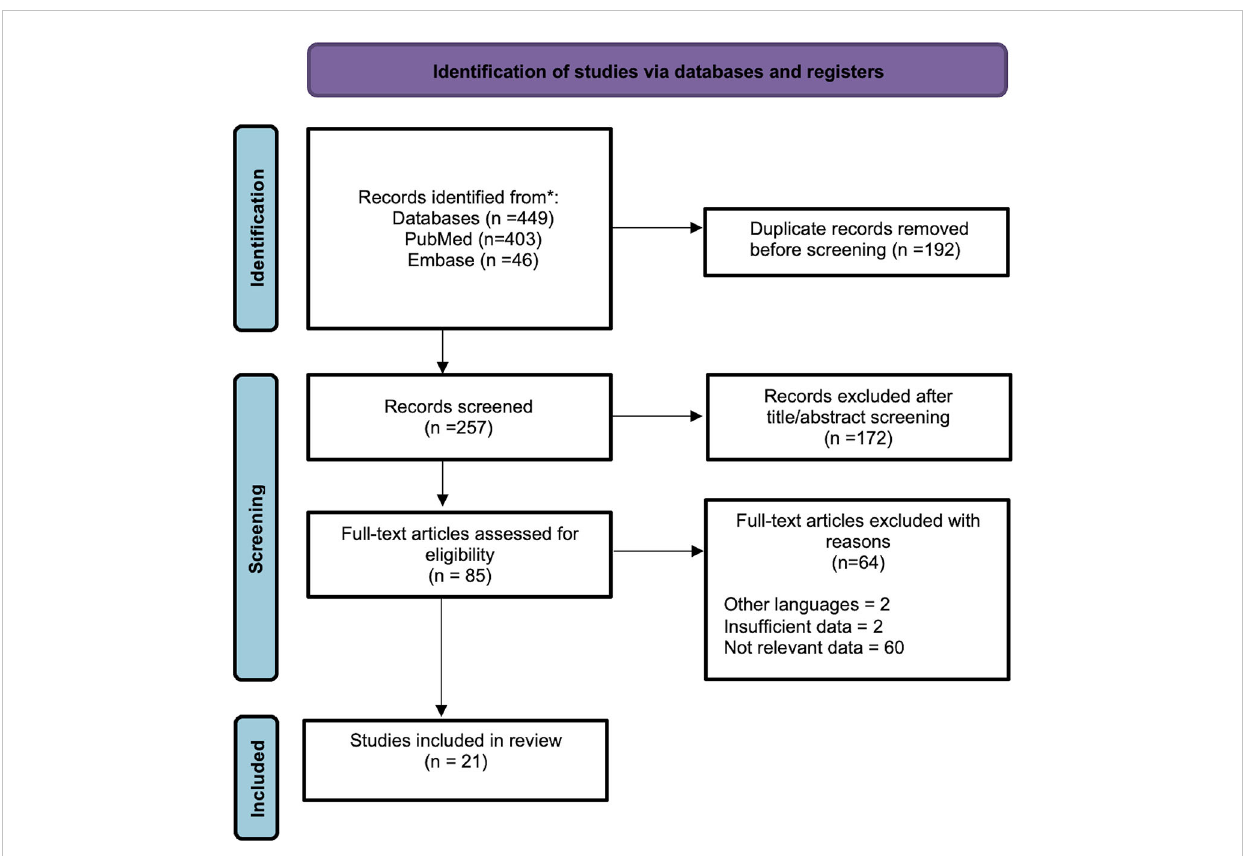
FIGURE 1 PRISMA fl owchart